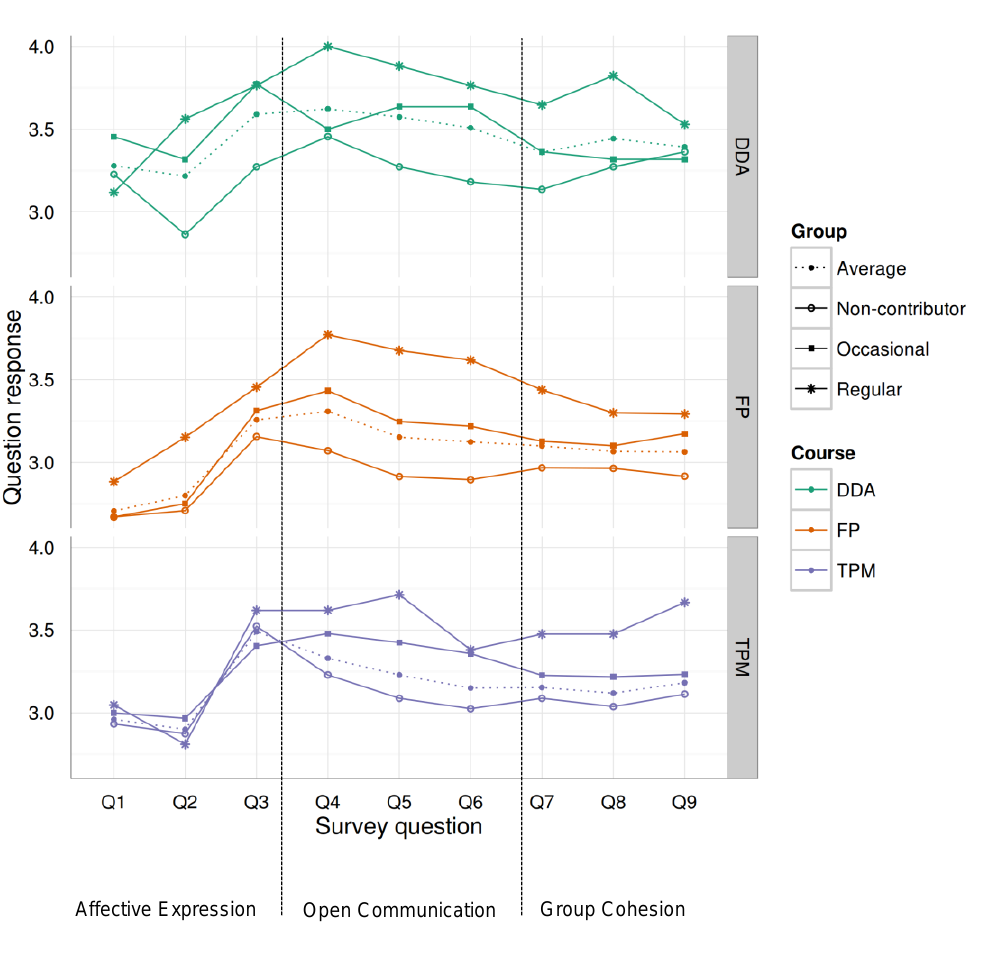
Figure 1 . Students’ social presence scores for each of the survey question (per group, per